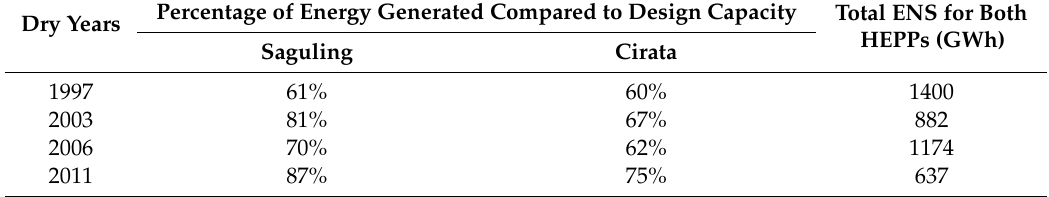
Table 7. Percentage of electricity production in dry years compared to design capacities. Source: own